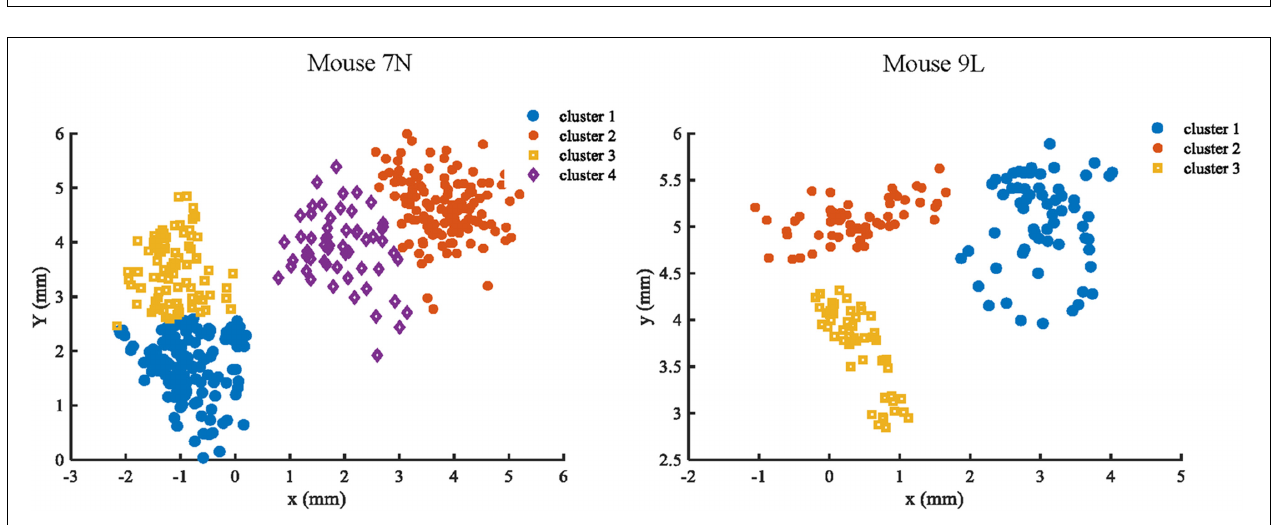
FIGURE 6 | Clustering results of mouse 7N (left) and mouse 9L (right) based on the k-Means method. Different clusters identified are represented by different colors.